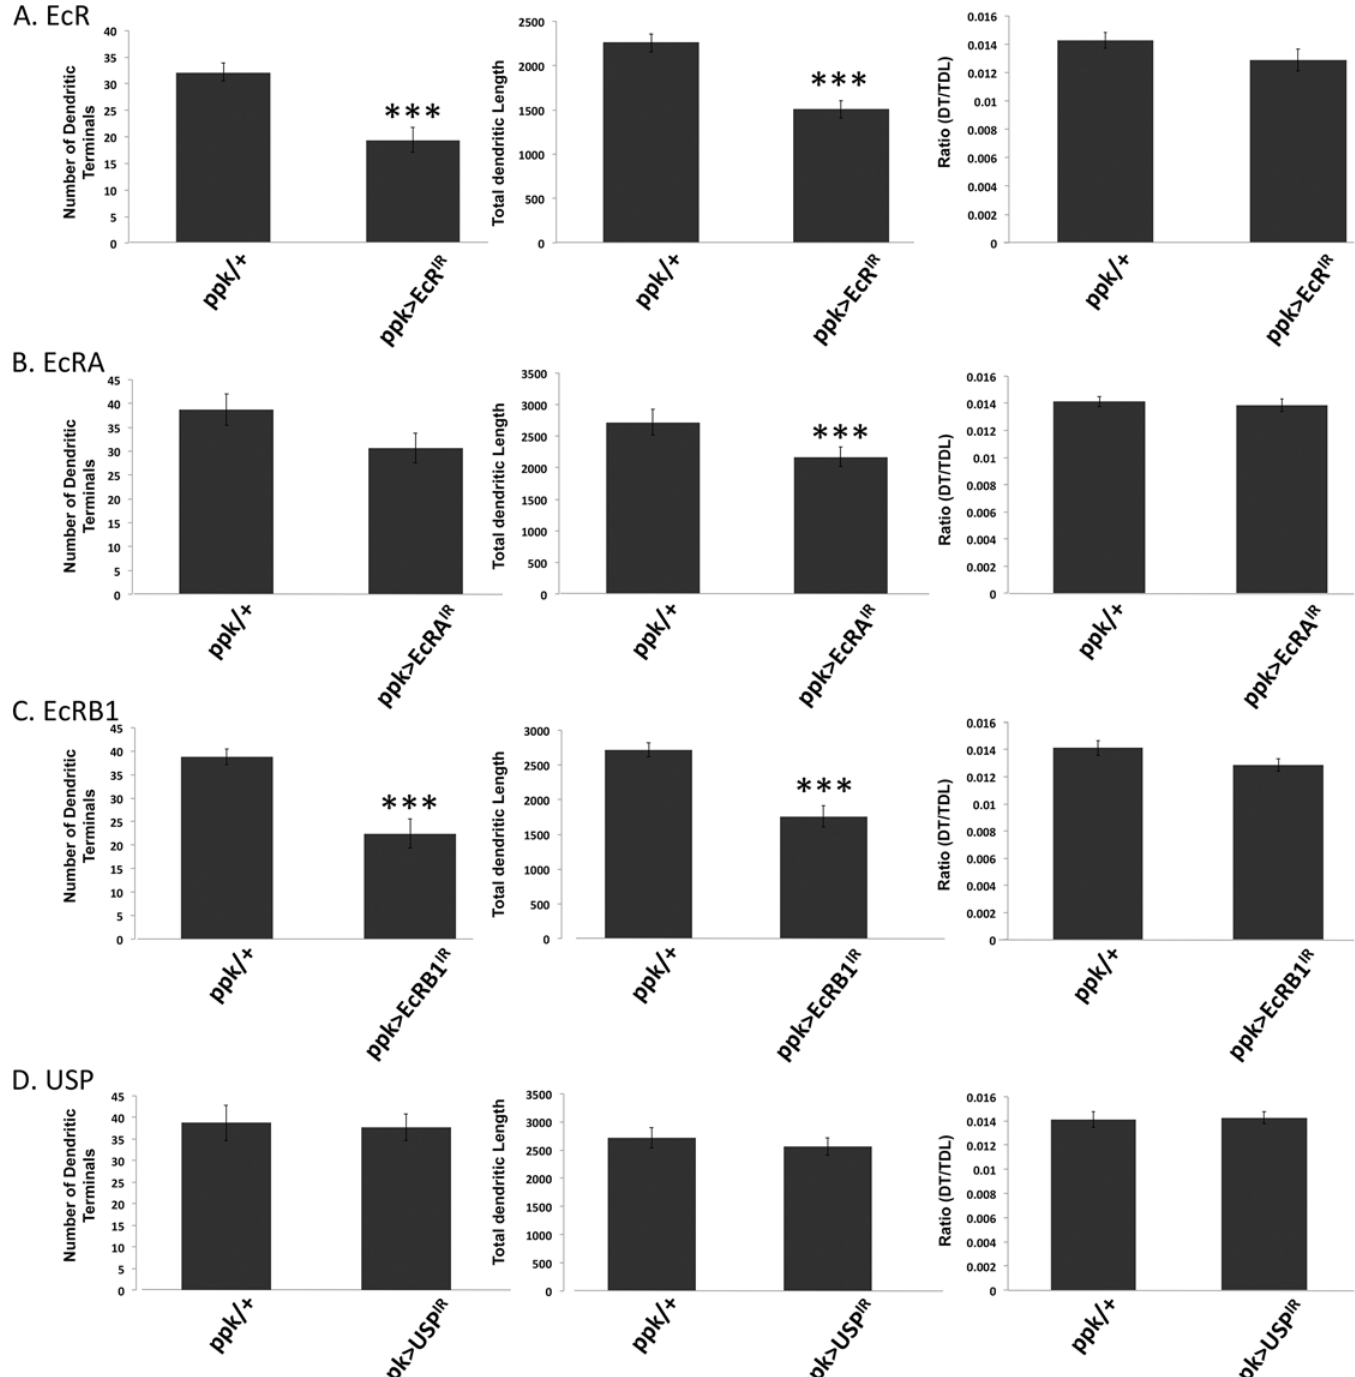
Fig 6. Morphometric analysis of class IV neurons in EcR, EcRA, EcRB1 and USP mutant flies. All neurons in the analysis were class IV ddaC neurons from third instar larvae. Experimental animals were compared to control animals for number of dendritic terminals (left), total dendritic length (center) and the ratio of dendritic terminals/total dendritic length as a measure of complexity (right). (A) EcR mutants have significantly fewer dendritic terminals and a reduced dendritic length, but maintain the same complexity. Control n = 20, EcR mutant n = 19. (B) EcRA mutants show reduced dendritic length, but both the number of dendritic terminals and complexity remain the same. Control n = 18, EcRA mutant n = 19. (C) EcRB1 mutants show a reduced number of dendritic terminals and reduced dendritic length, but are similar in complexity. Control n = 18, EcRB1 mutant n = 17. (D) USP mutant animals show no difference in number of dendritic terminals, total dendritic length or complexity. Control n = 18 USP mutant n = 16. *** indicates p < 0.001.